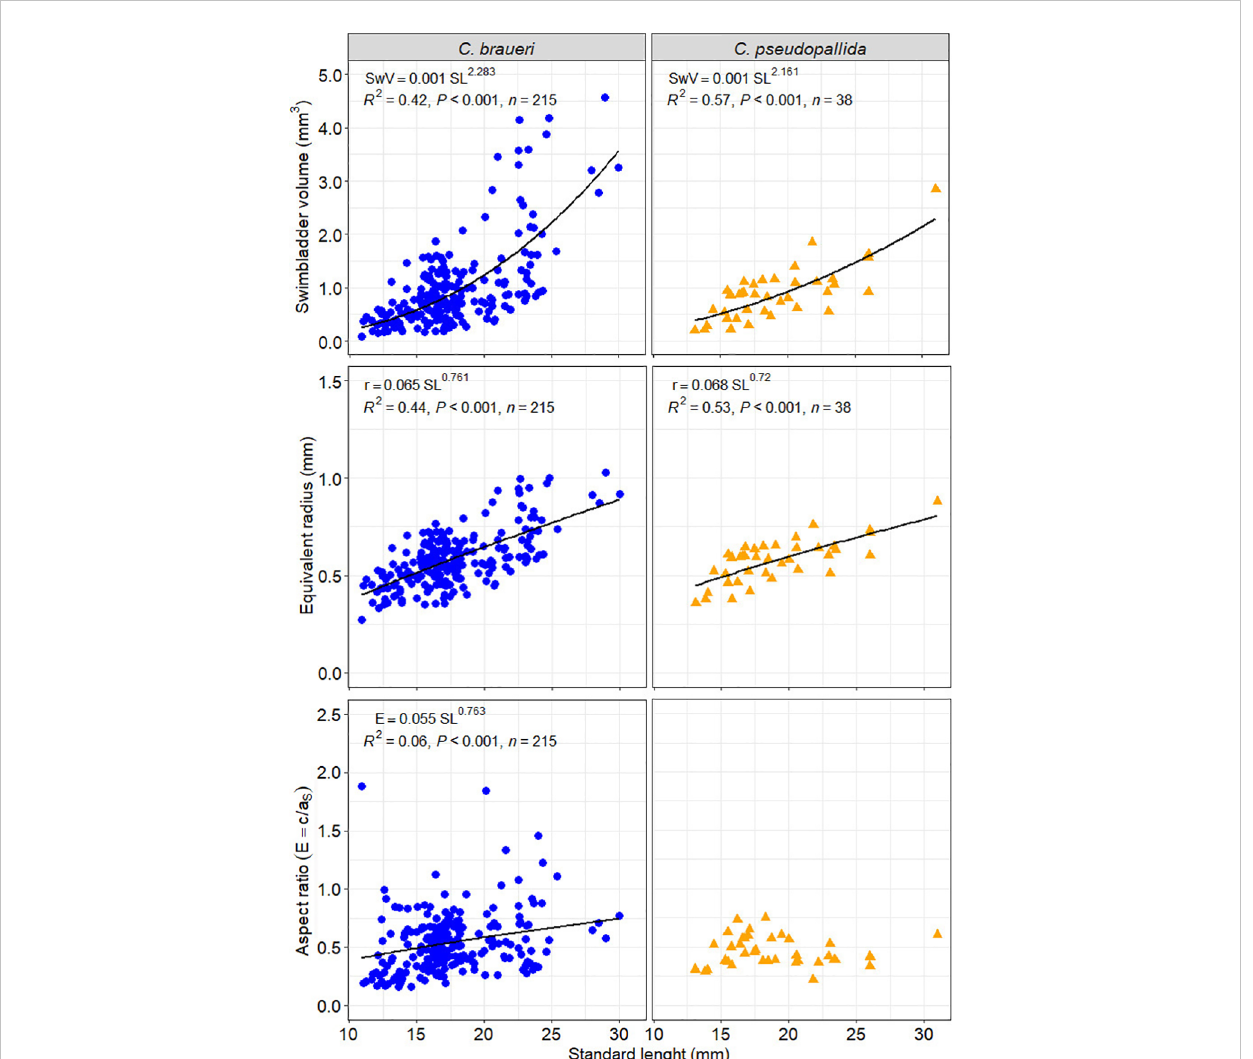
FIGURE 11 Relationship between standard length (SL, mm) and swimbladder volume (SwV), equivalent radius (r), and aspect ratio ( E = c = a ), where a is the longitudinal semi-axis and c the width semi-axis for C. braueri (blue dots) and C. pseudopallida (yellow